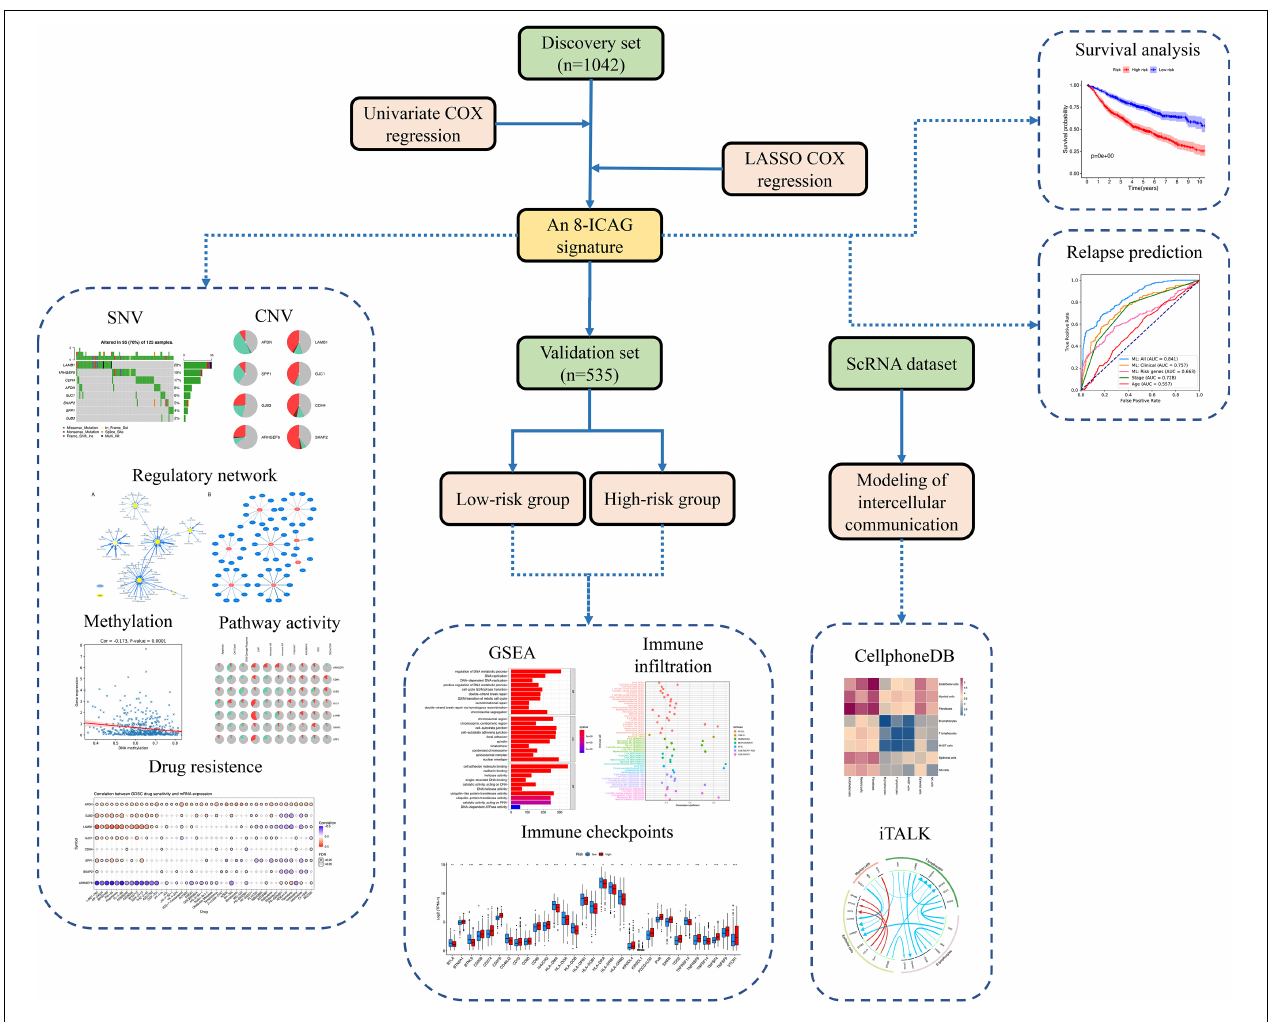
FIGURE 1 | Flow chart of the design of the present